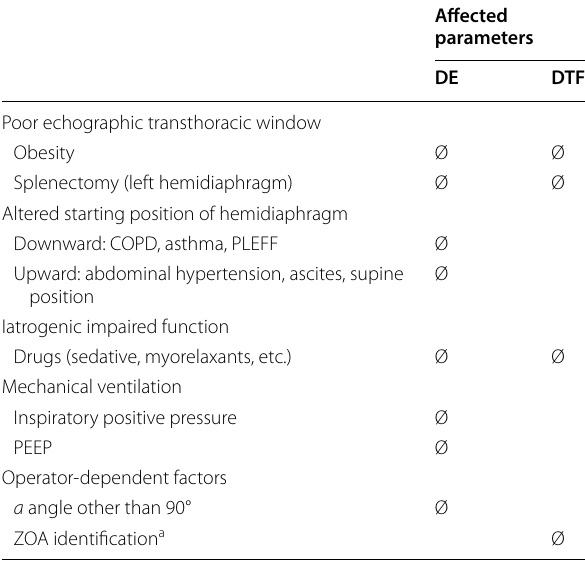
Table 1 Most common bias to consider before an ultrasound assessment of diaphragmatic